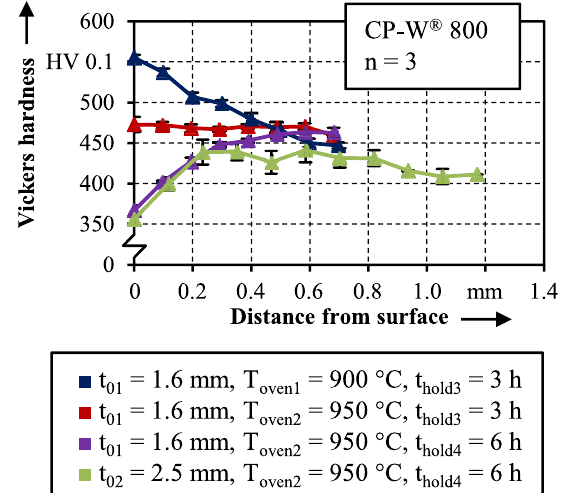
Fig. 6. Distribution of Vickers hardness along the sheet thickness of selected samples with a sheet thickness of 1.6 and 2.5mm after carburization of three and six hours at 900 and 950 °